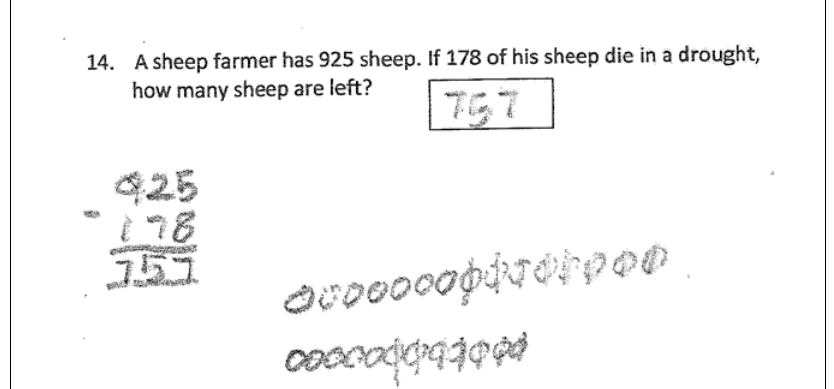
Figure 7: Extract 1 from grade 4 script, learner